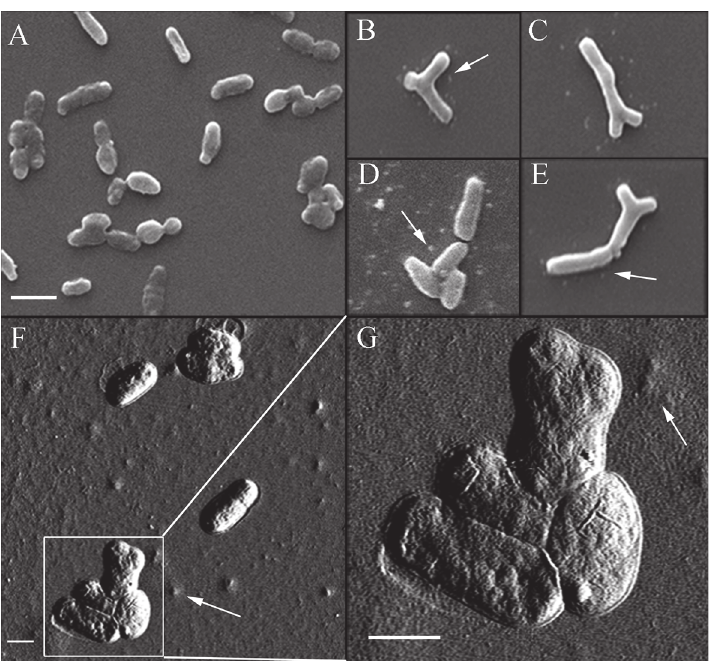
Fig 1. SEM and AFM images highlight the infrequent phenotype in 2,4-D treated Rlv . Most of the untreated (A) and treated (D) Rlv appeared normal but a small number of the 2,4-D (0.4 mM) treated cells appear ‘ Y ’ shaped (C, E, F, G) and some appeared to branch (B). F and G show one (top) of the four clustered cells with clear demarcation for initiation of the ‘ Y ’ shaped phenotype. Arrows indicate extracellular matrix on the substrate surface. Scale bar A-E 2 μ m, F and G 1 μ